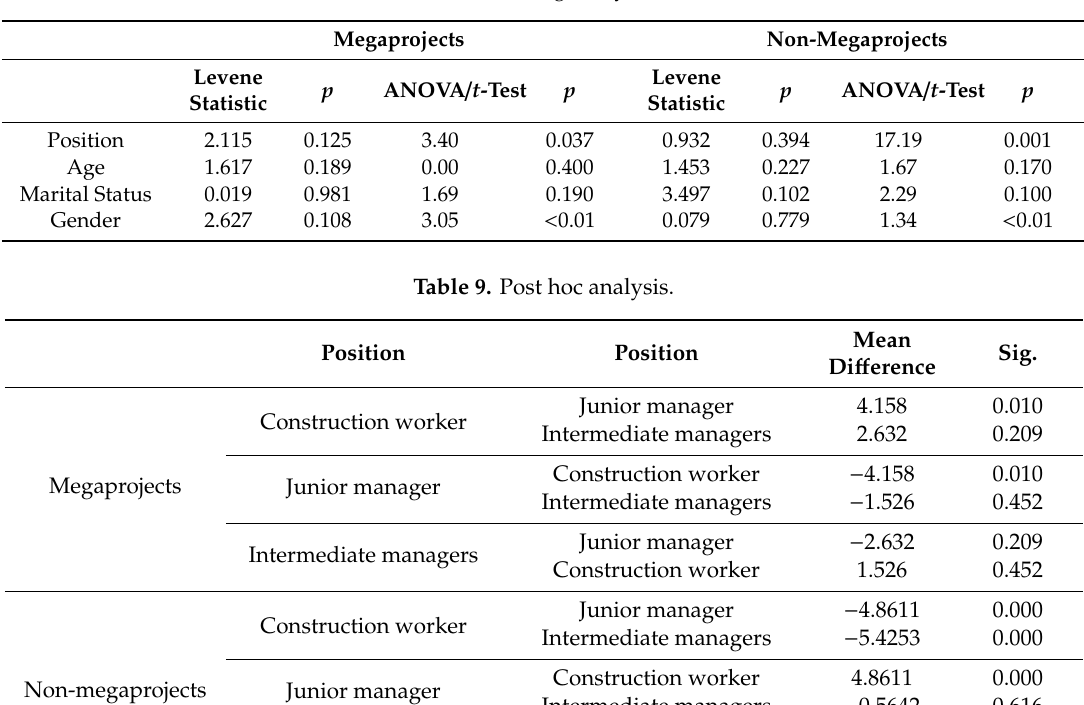
Table 8. Test of homogeneity of variance.